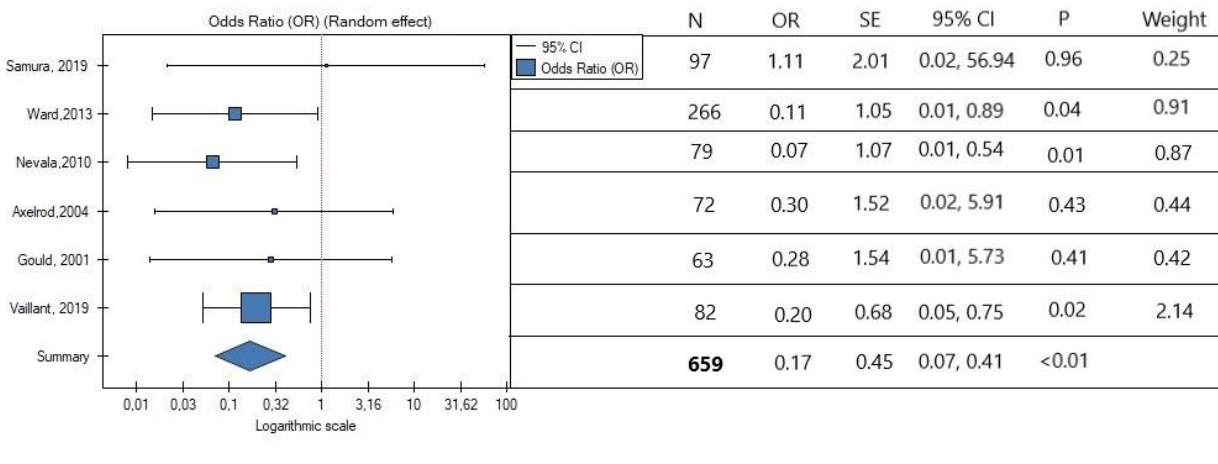
Figure 2. Association between IMA embolization and rate of secondary reinterventions. The horizontal line represents 95% confidence intervals (CIs). N, number of patients; OR, odds ratio; SE, standard error. Data referred from reference [22 – 27].